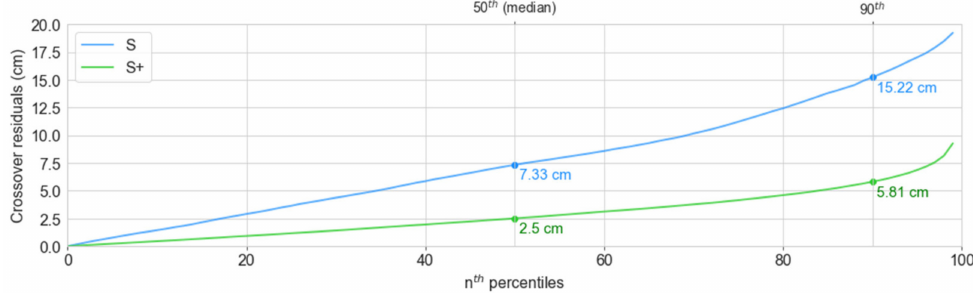
Figure 12. n th percentiles distribution of the crossover residuals, for the S (blue) and S+ (green) corrections. The 50th and 90th percentiles are represented by vertical lines, and associated values are displayed for each